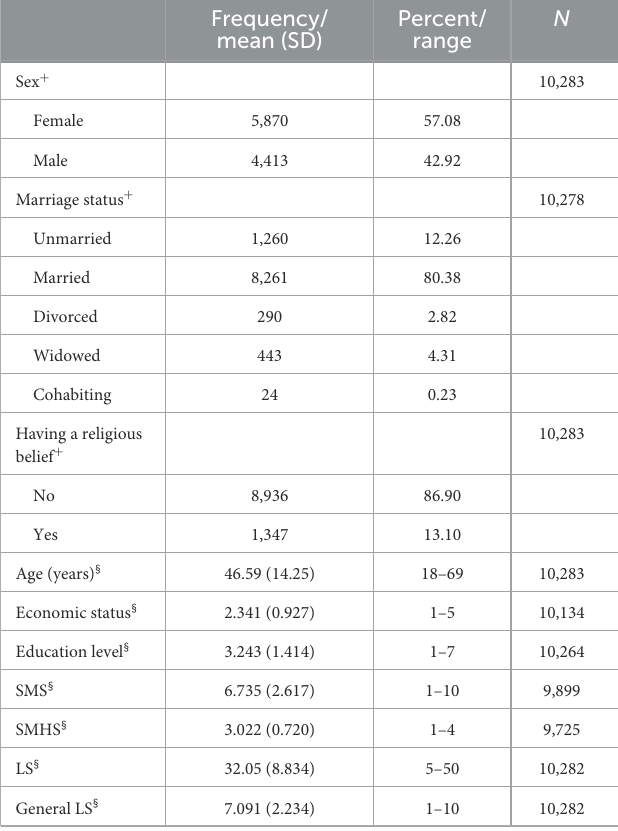
TABLE 1 Characteristics of the study